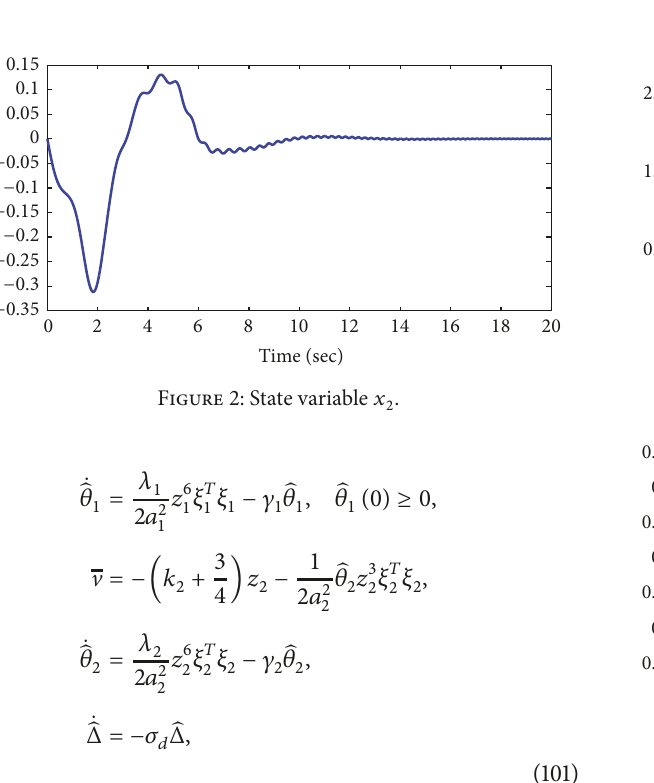
Figure 3: The true control input V .